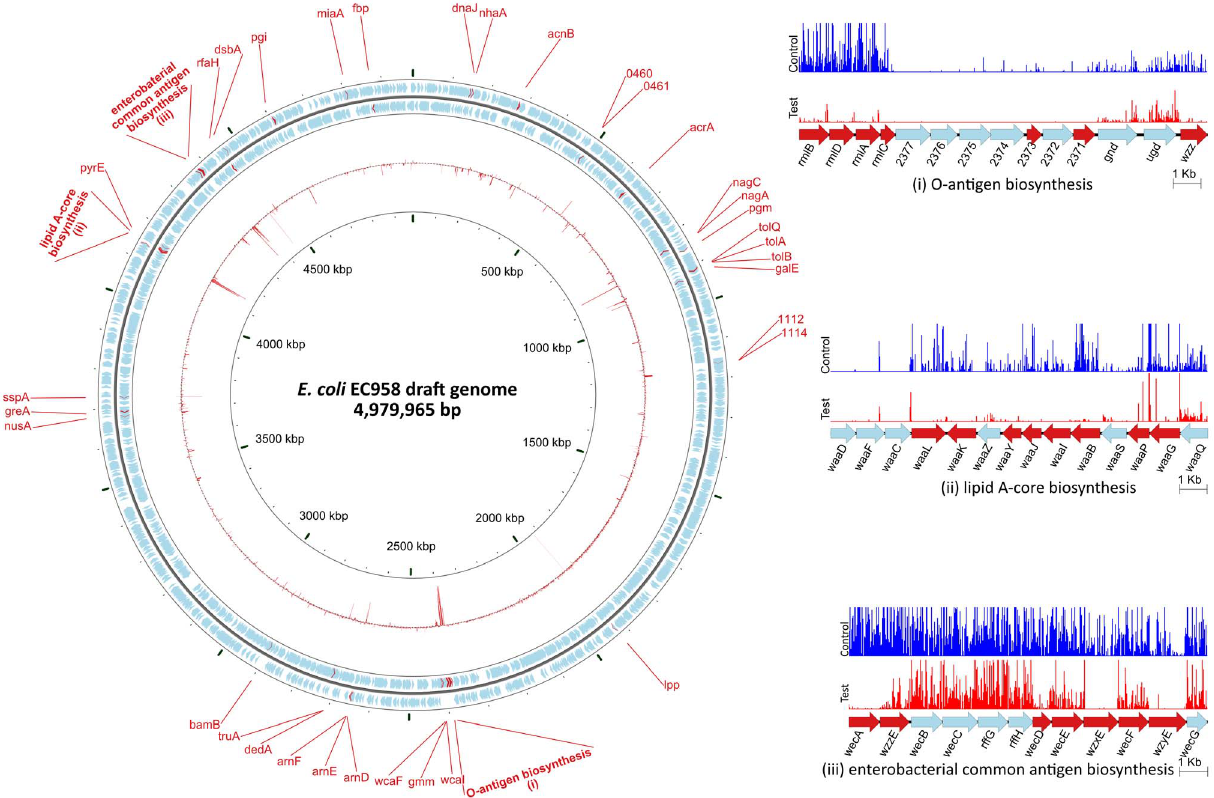
Figure 4. Overview of the E.coli EC958 serum resistance genes. The circular diagram depicts the location of 56 serum resistance genes on the E. coli EC958 genome. The two outer rings containing blue and red arrows illustrate the CDS and serum resistance genes, respectively, on the forward and reverse strand of the genome. The inner red ring represents the logFC between the control and the test samples for each CDS. The three insets represent a close-up look at three regions on the genome with the graphs showing the location and relative number of each mutant found in the control (blue) and test (red) samples.